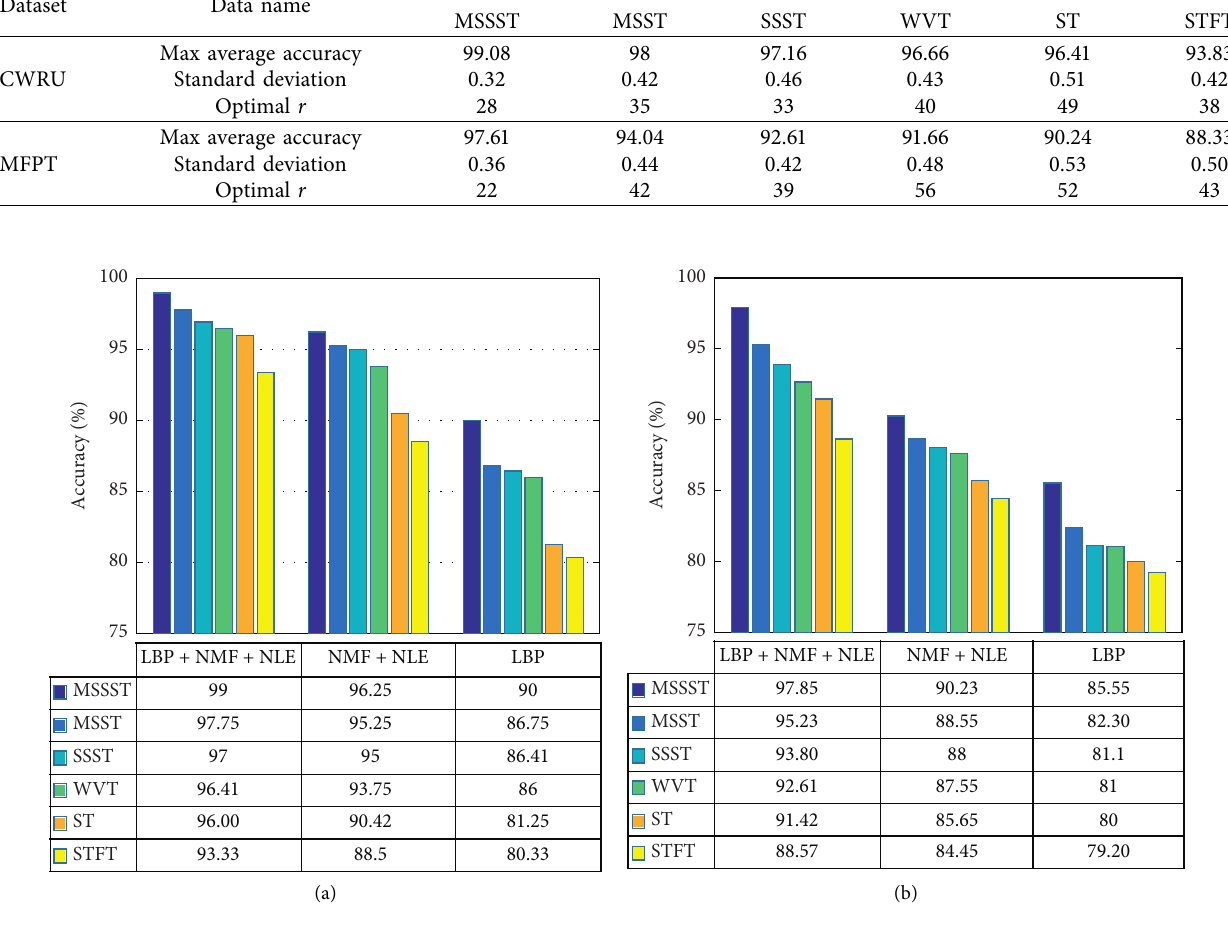
Figure 7: The recognition accuracy of testing set under different methods (a) in the CWRU dataset; (b) in the MFPT